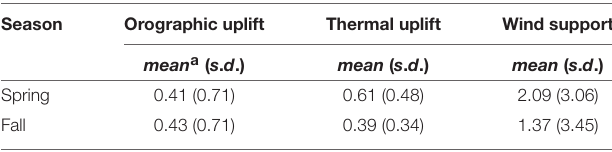
TABLE 1 | Summary statistics of flight subsidies encountered by migrating golden eagles that summer in Alaska.